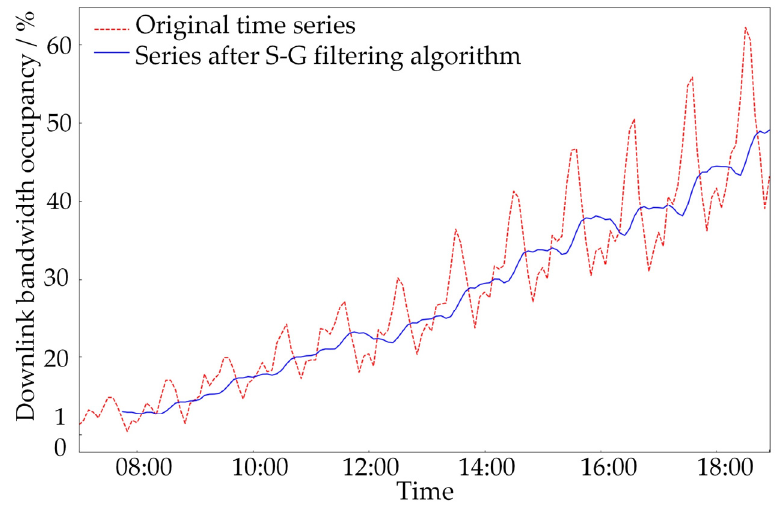
Figure 5. Effect picture of pre-processing data by the sliding window method.